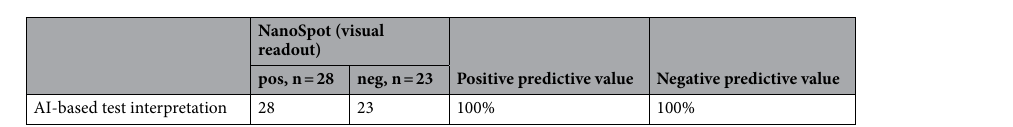
Figure 5. NanoSpot adaptation to emerging SARS-CoV-2 variants. ( a ) SyproRuby-stained SDS PAGE of ~ 20 µg of NanoSpike N501Y, which was expressed in Expi293F cells and purified by one-step affinity purification. Protein yield from 25 ml of Expi293F-cell cultures was 2.5 mg. Defined amounts of BSA are shown for comparison. ( b ) Hemagglutination assay based on samples from a convalescent COVID-19-patient that was treated with indicated proteins. Three dilutions of the serum and three time points were used to reveal potential differences in agglutination activity.